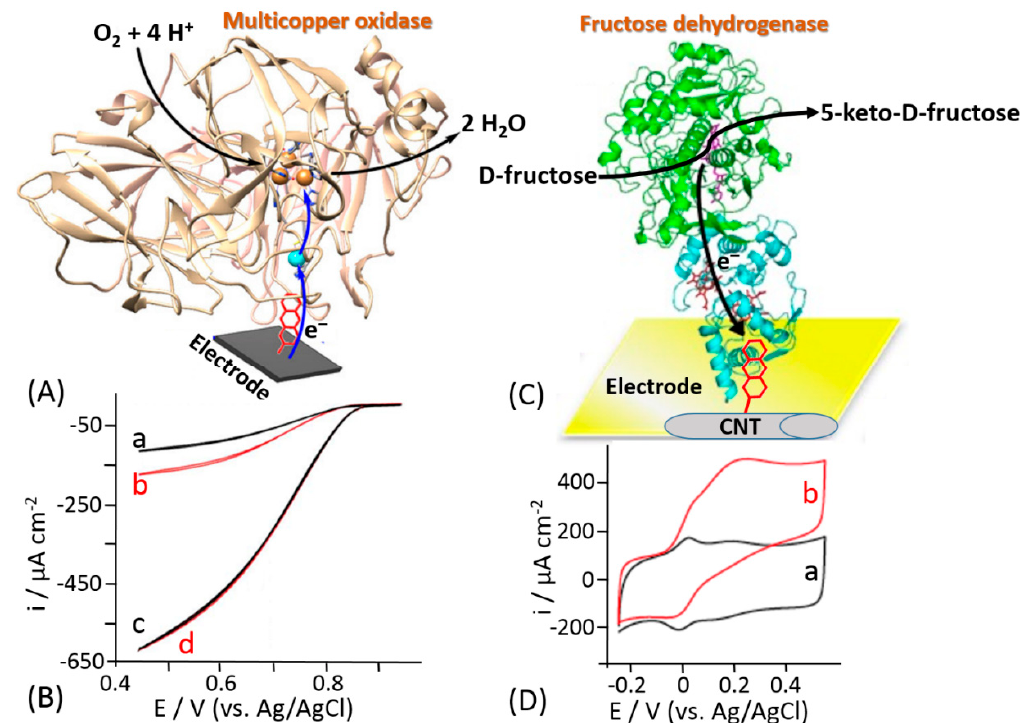
Figure 15. ( A ) Laccase (multicopper oxidase) site-specific immobilization due to the enzyme binding to the surface-located aromatic species. ( B ) The electrocatalytic activity of a film of Pycnoporus cinnabarinus laccase lcc3-1 (PcL) on an electrode without aromatic species and random orientation of the adsorbed enzyme (a–b) and on an electrode functionalized with the aromatic species providing orientation of the enzyme favorable for the DET (c–d). Cyclic voltammograms (a) and (c) correspond to the catalytic waves immediately after spotting on laccase solution. Cyclic voltammograms (b) and (d) show the catalytic waves after additional treatment of the modified electrode with a new portion of the enzyme. Potential scan rate was 5 mV s − 1 . ( C ) Fructose dehydrogenase site-specific immobilization due to the enzyme binding to the surface-located aromatic species. ( D ) Cyclic voltammograms measured with fructose dehydrogenase-electrode modified according the scheme shown in ( C ); in the absence (a) and presence of 10 mM D-fructose (b). The background electrolyte was 50 mM acetic buffer, pH 4.5; potential scan rate was 10 mV s − 1 . (Part A was adopted from [3] with permission; part B was adopted from [170] with permission; part D was adopted from [178] with permission.).